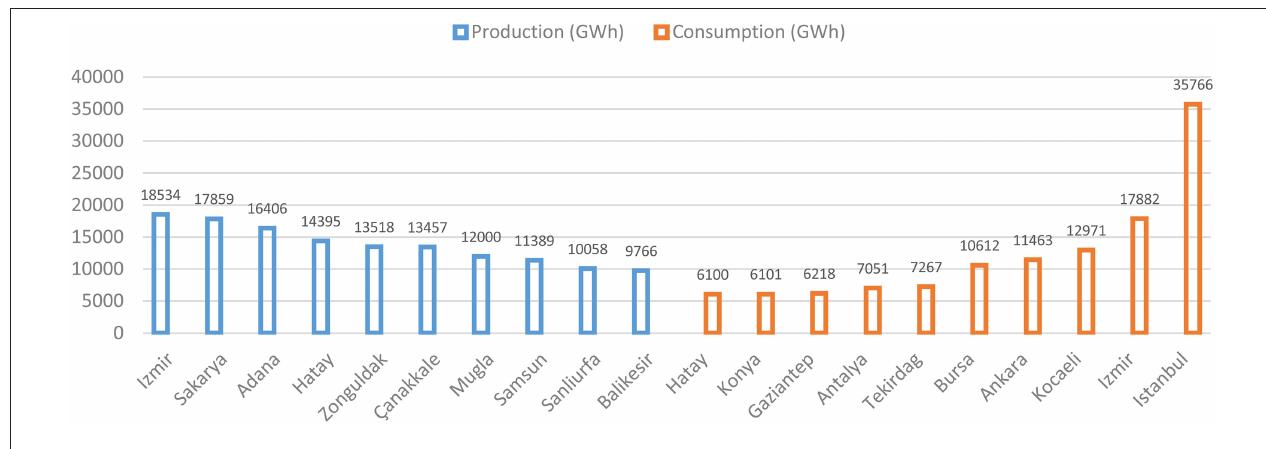
FIGURE 14 | Top ten cities in Turkey producing and consuming electricity Source: TURKSTAT 21 .